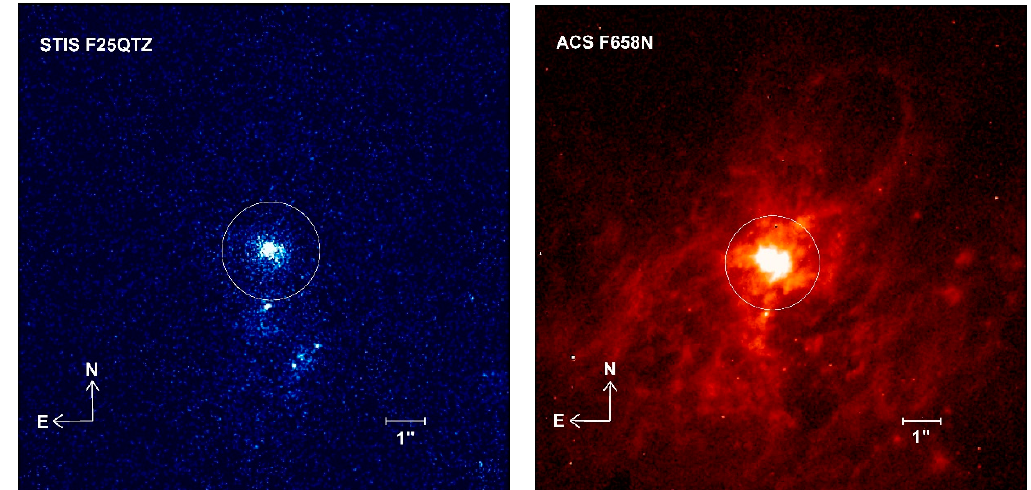
Figure 16. STIS UV (left) and Advanced Camera for Surveys ( ACS ) H α (right) images of the star cluster and H II region in II Zw 40. Table 1600. Å. The circle denotes the position of the COS aperture, which encompasses a physical area of 135 pc in diameter. From [76].